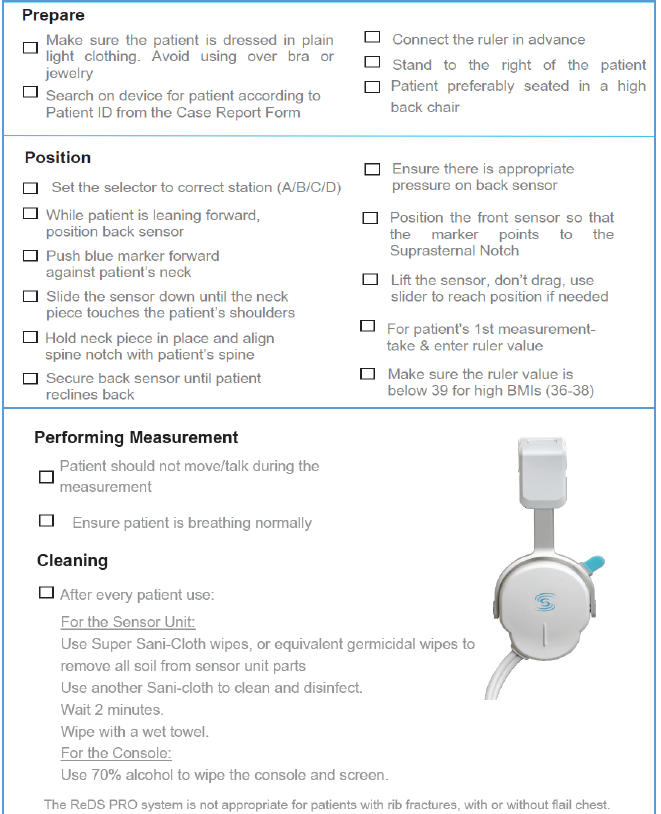
Figure 2. Operating instructions of the ReDS™ Pro System device.